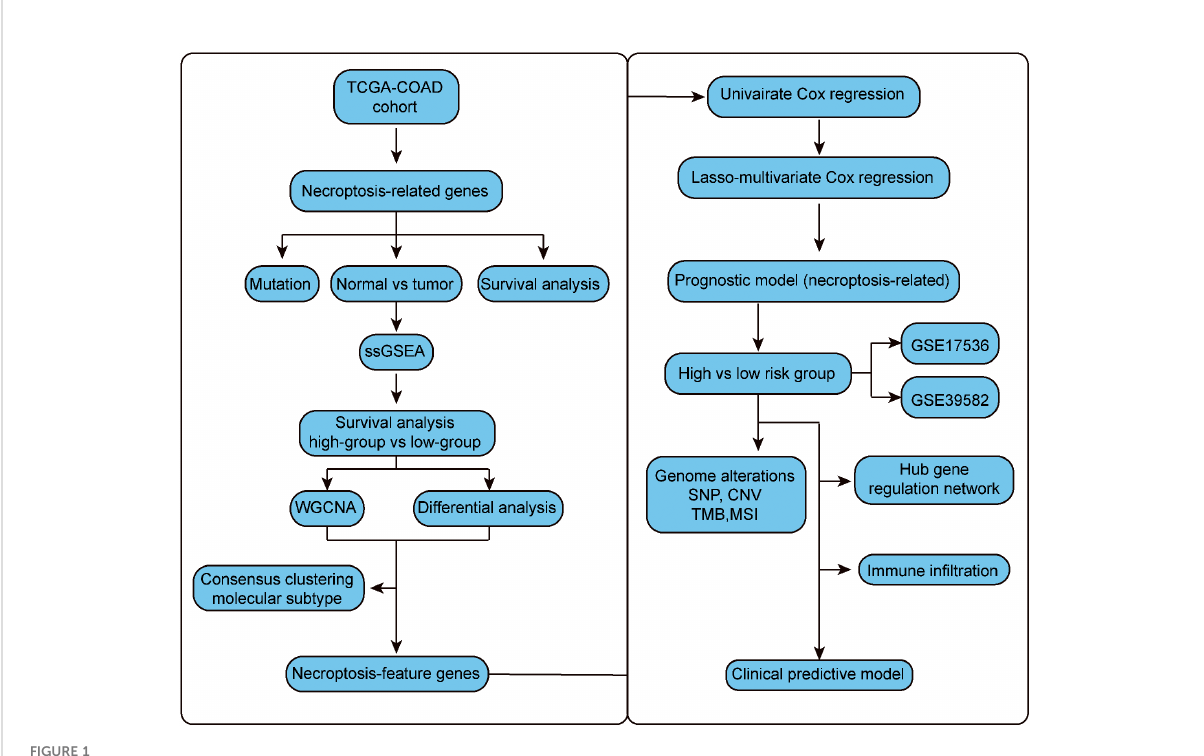
FIGURE 1 The fl ow